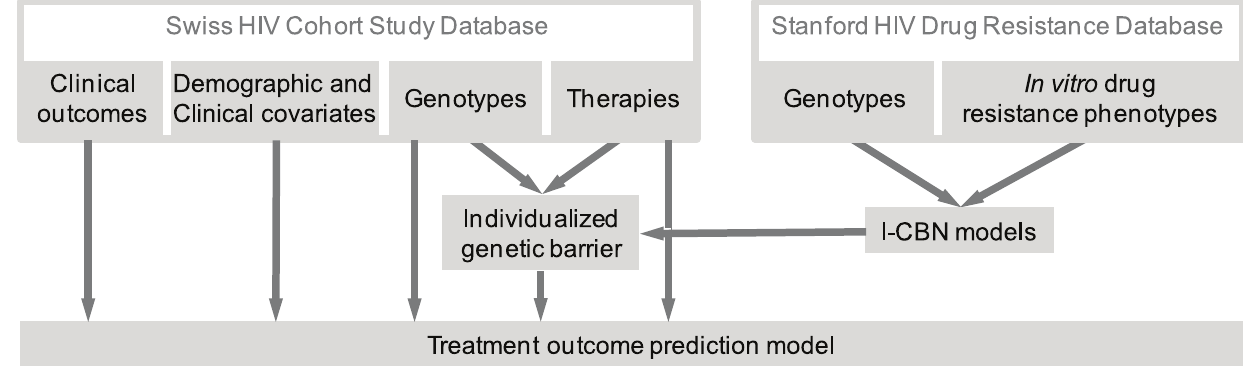
Figure 2. Data flow. Matched pairs of viral genotype and drug resistance phenotype from the Stanford HIV Drug Resistance Database (top right) were used to learn I-CBN models for all drugs separately. The drug-specific individualized genetic barriers (IGBs) are derived from these models. The IGB to regimen is computed for each genotype-therapy pair in the Swiss HIV Cohort Database and its predictive power is assessed in prediction models that also account for classical demographic, clinical, and genetic covariates.